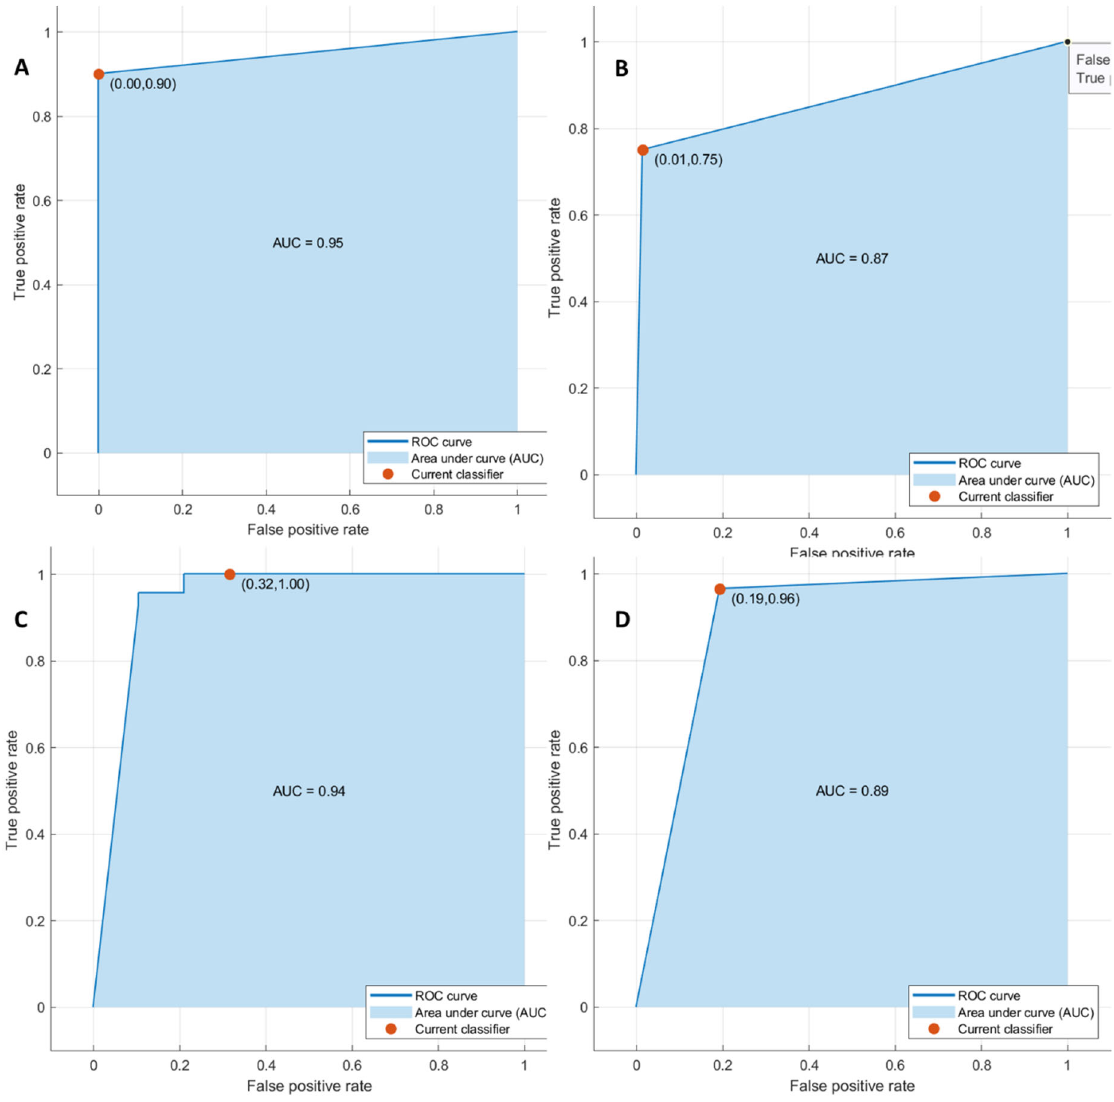
Figure 2. ROC curves of KNN with respect to the front of tumor growth ( A ), tumor budding ( B ), tumor mucinous type ( C ), and recurrence presence ( D ) obtained considering significant features in internal training set.